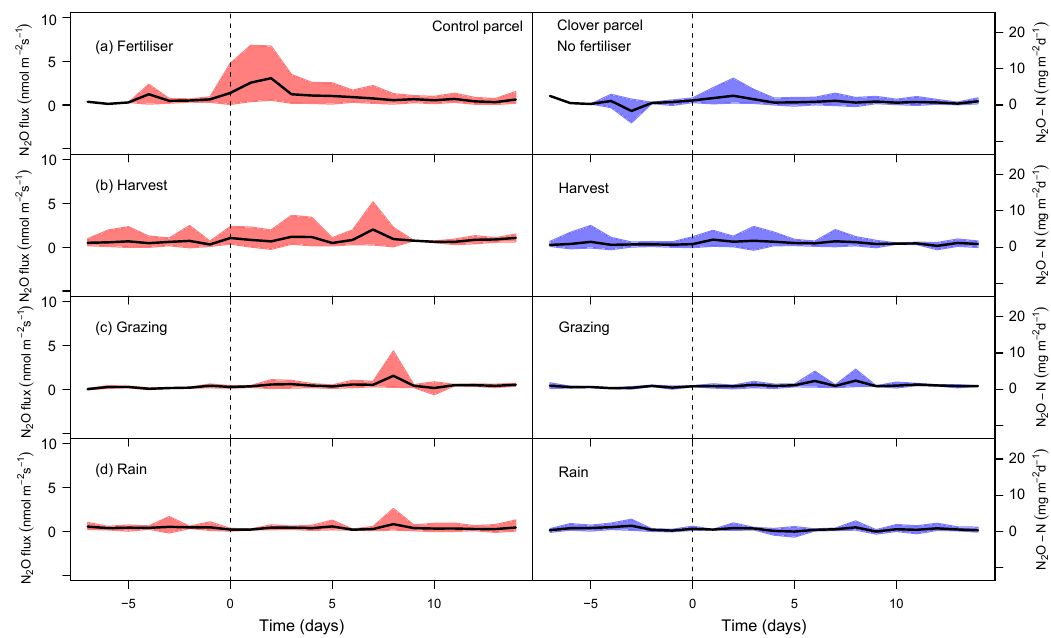
Figure 7. N 2 O fluxes (bold lines: average; colour bands: interquartile range of daily means across all events in 2015 and 2016) in the control and the clover parcels from 1 week before to 2 weeks after management events: after (a) organic fertiliser application, (b) harvests, (c) grazing events, and (d) rain events. The black dashed line indicates the start of an